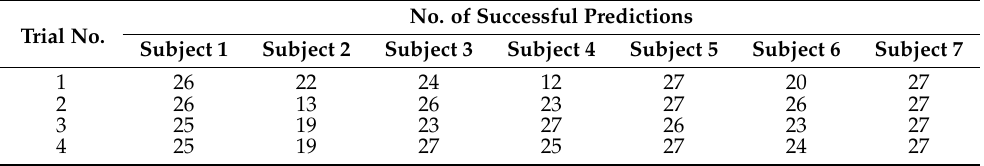
Table 11. Number of prediction successes: pinch. Trial